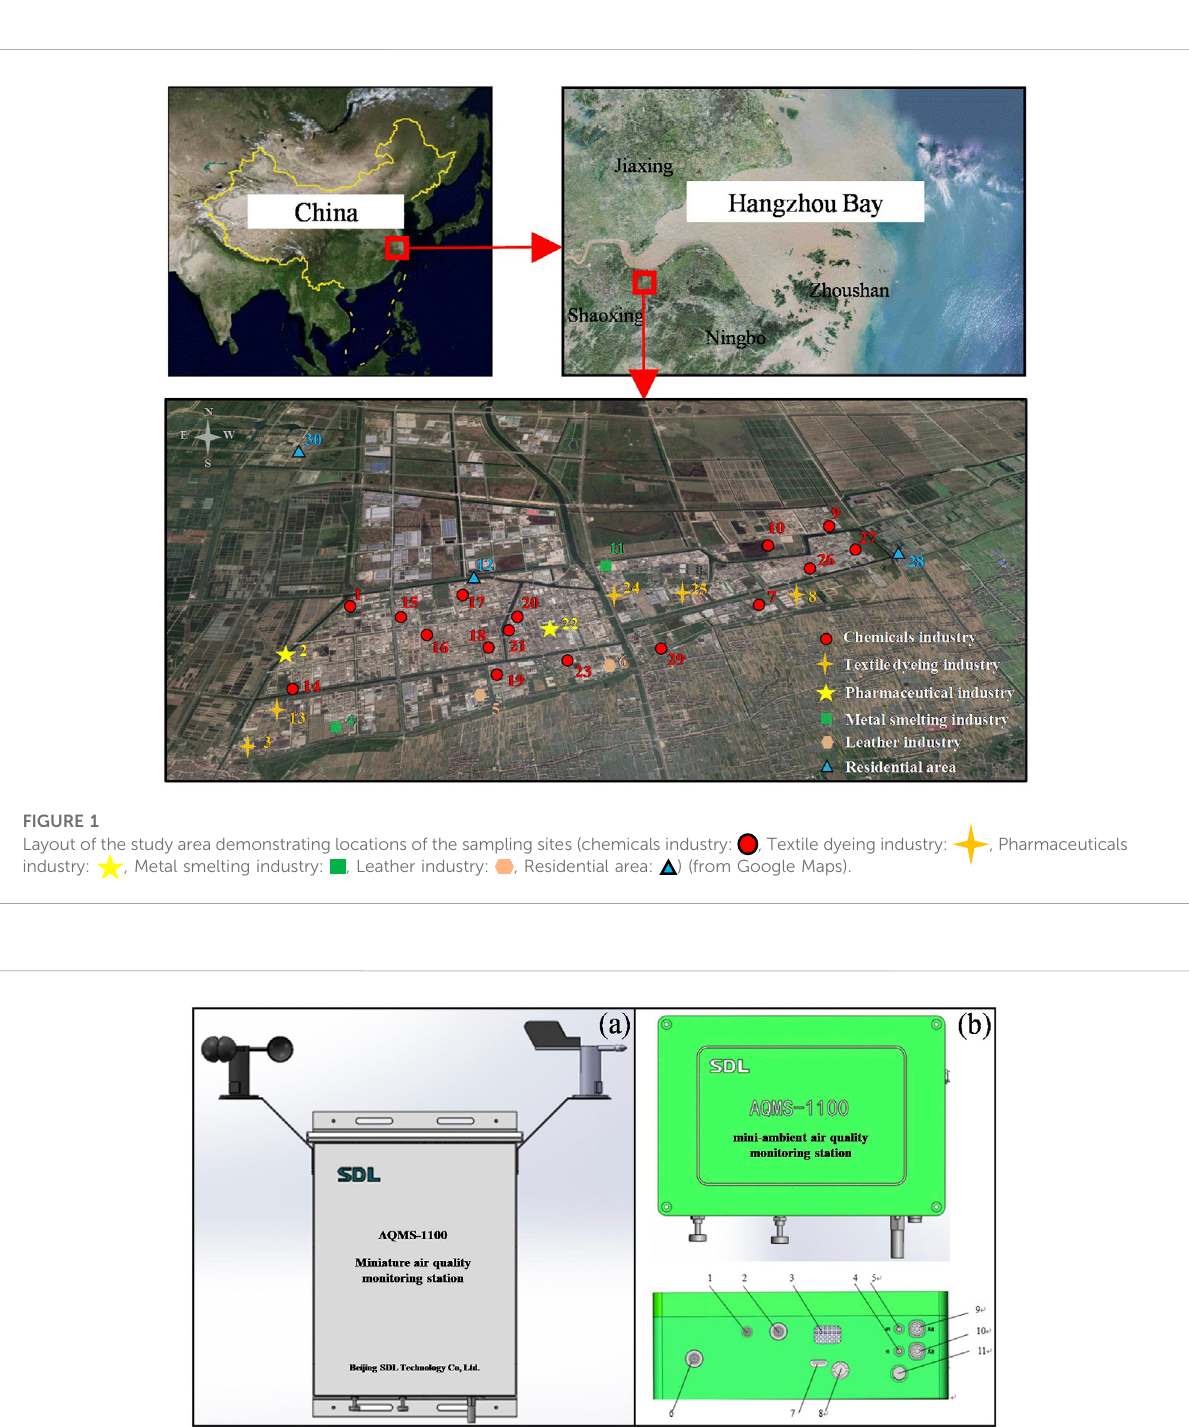
FIGURE 2 The overall appearance of AQMS (A) . The host of AQMS (B) . the air sensors are installed inside the device host. The interfaces of the device are introduced as the following: 1 air outlet, 2 PMS15 template air inlet, 3 air outlet, 4 4G antenna interface, 5 GPS antenna interface, 6 air inlet of